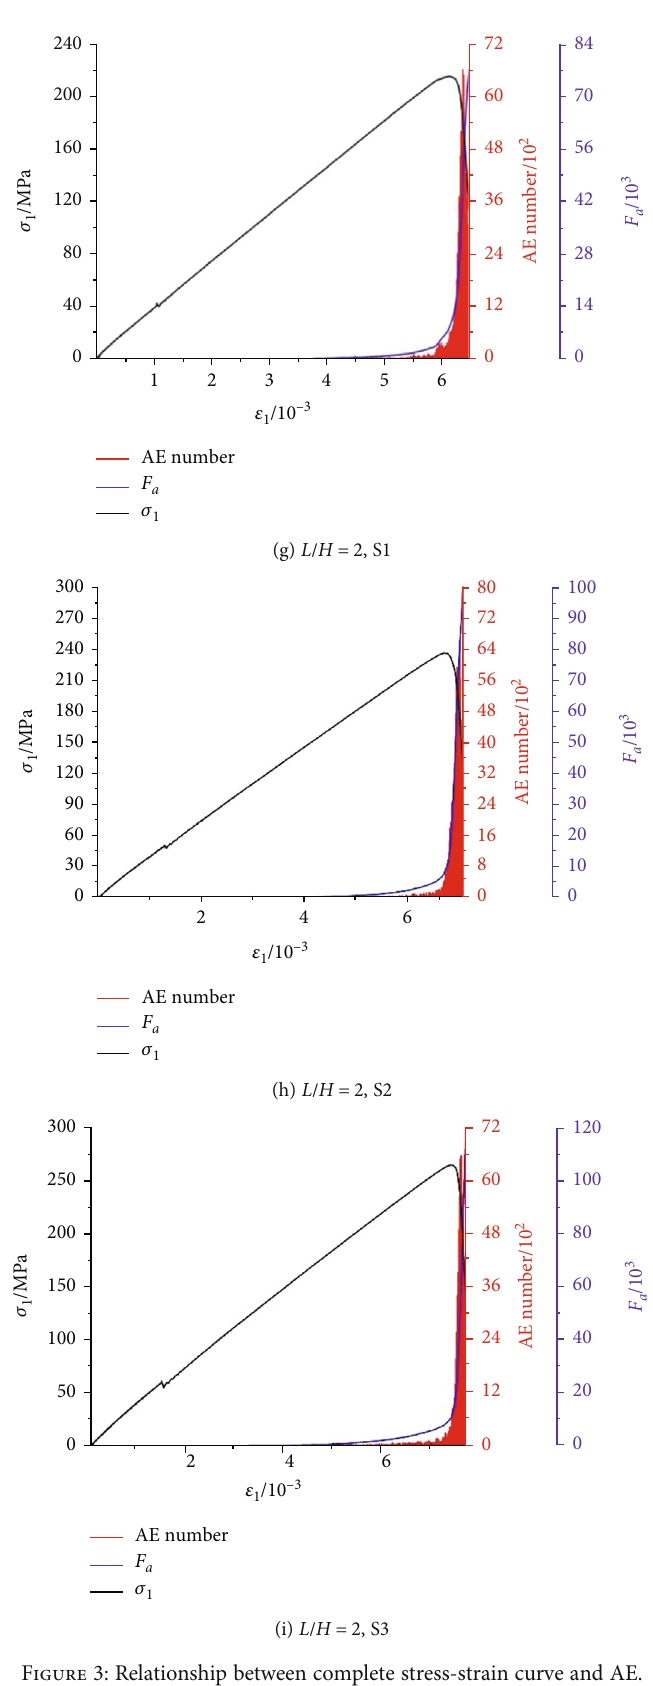
Figure 3: Relationship between complete stress-strain curve and